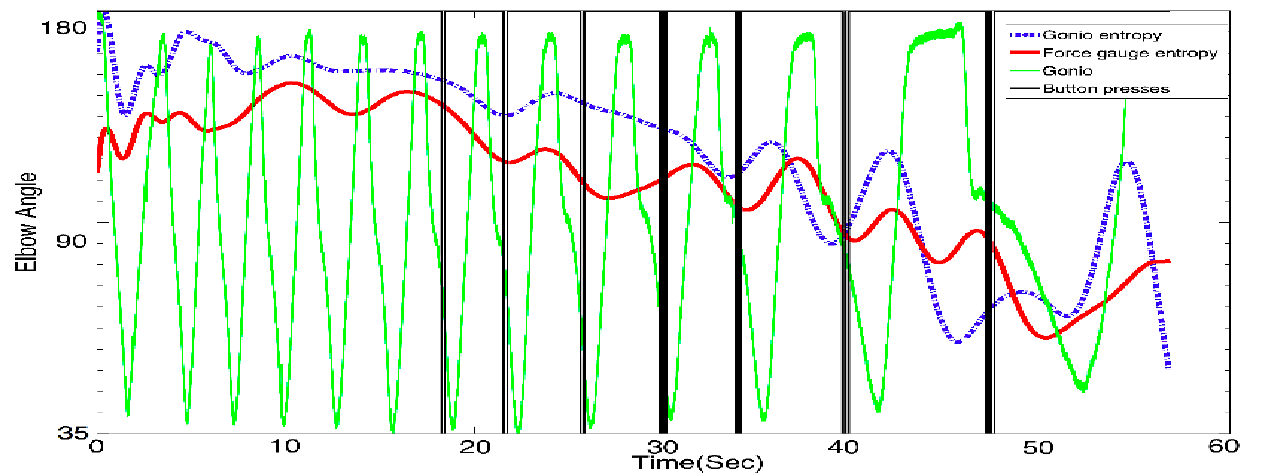
Figure 2. Movement aspects from one of the trials which aided in labelling the sEMG